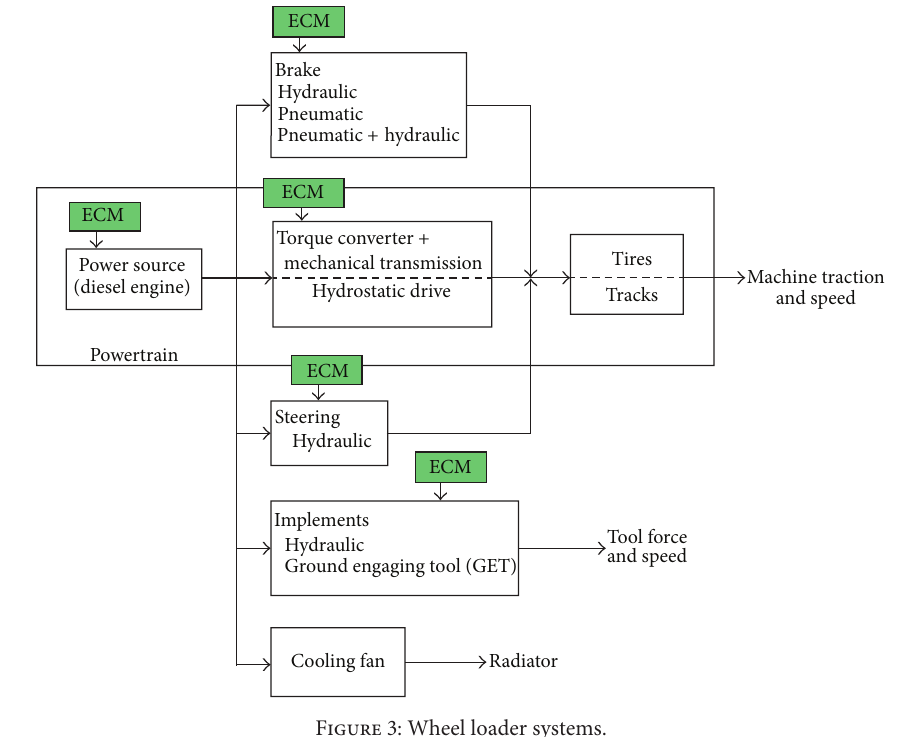
Figure 3: Wheel loader systems.